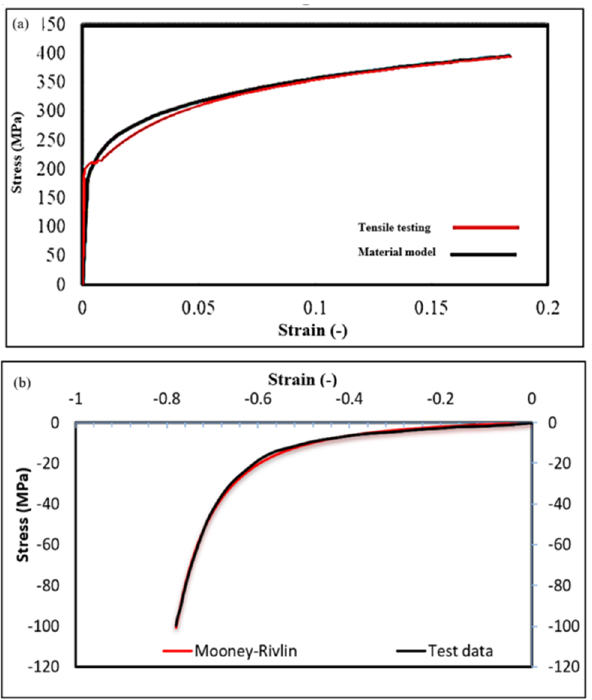
Figure 3. ( a ) The material flow model and the tensile testing curve of DC05 steel sheet; ( b ) The compression diagram compared to Mooney–Rivlin model for Polyurethane-A90 punch .